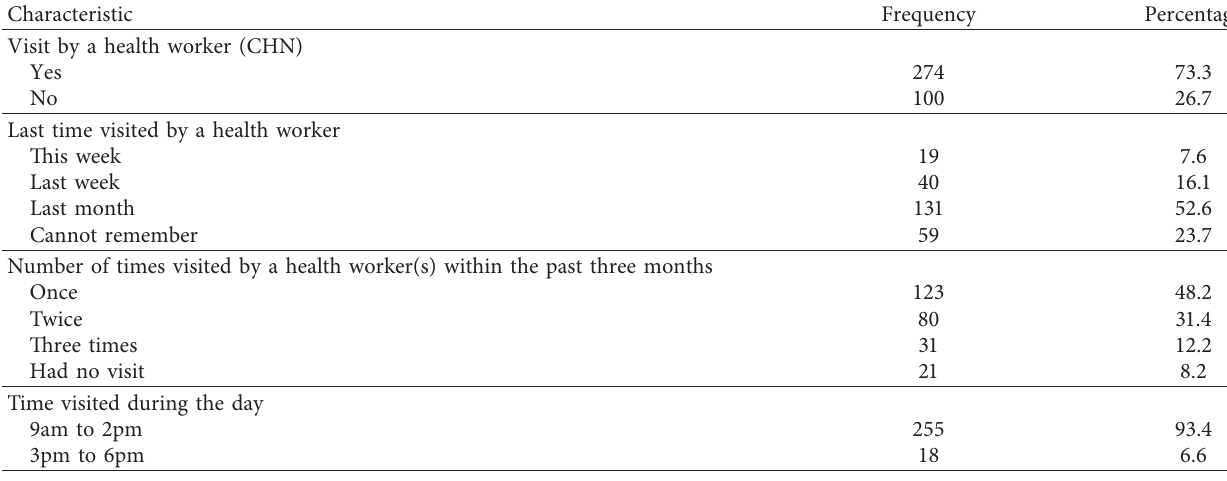
Table 2: Practice of home visits in AD (household